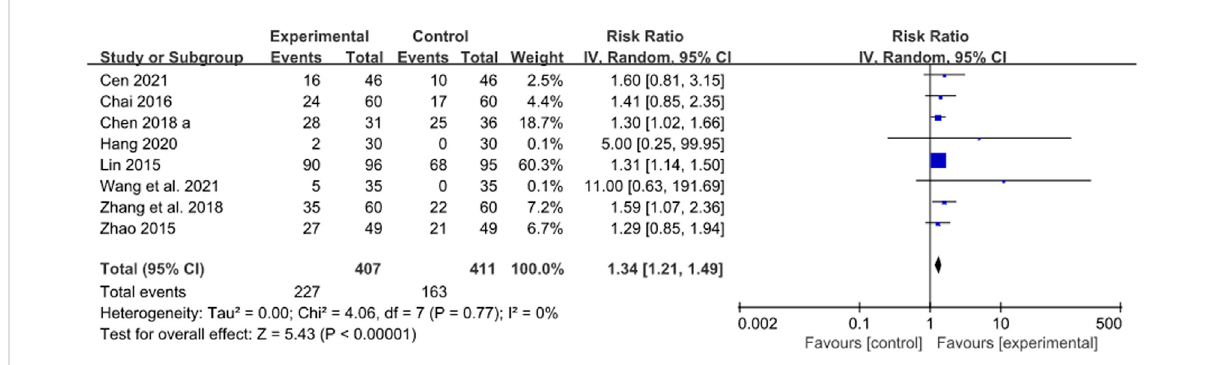
FIGURE 8 Forest plot of cure rate after JWC with the duration of 2 weeks.